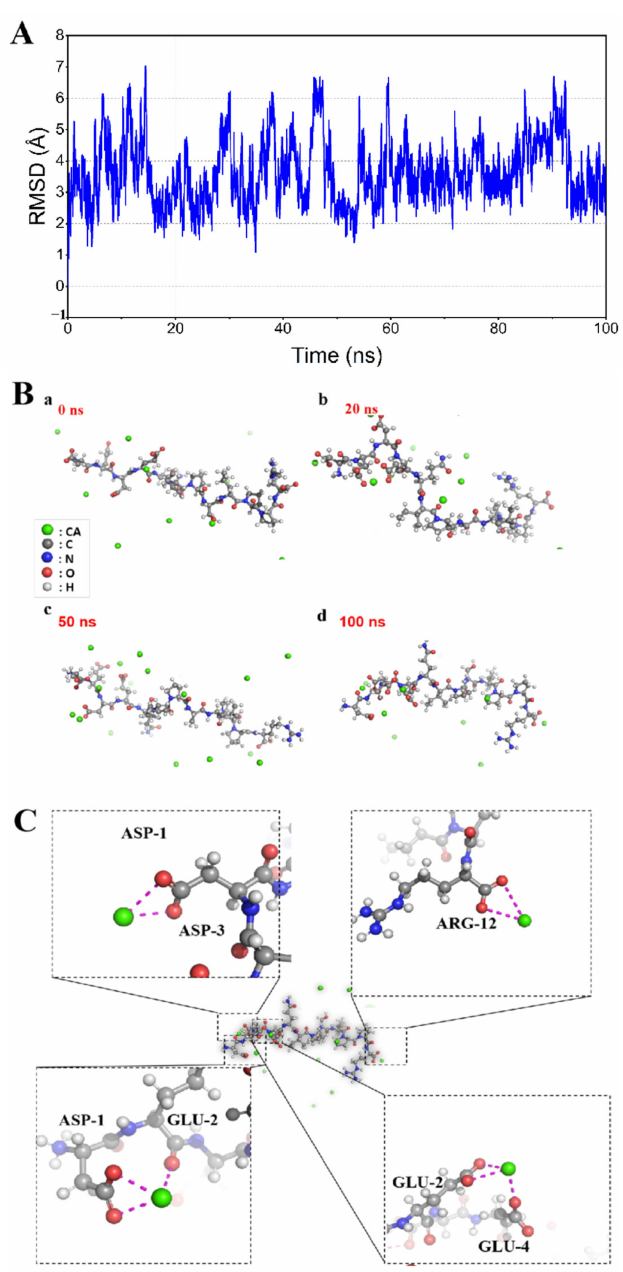
Figure 1. ( A ) RMSD stability of plots of the MD simulations. ( B ) Molecular docking and the structure of DEDEQIPSHPPR-calcium complex at different times (0 ns, 2 ns, 50 ns and 100 ns) of conformations. ( C ) Snapshot of molecular interaction capture at the last frames from the 100 ns MD simulations for the DEDEQIPSHPPR-calcium